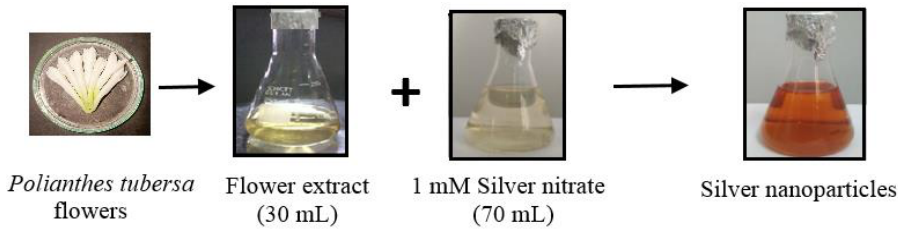
Figure 1. Synthesis of silver nanoparticles from the P. tuberosa flower extract.